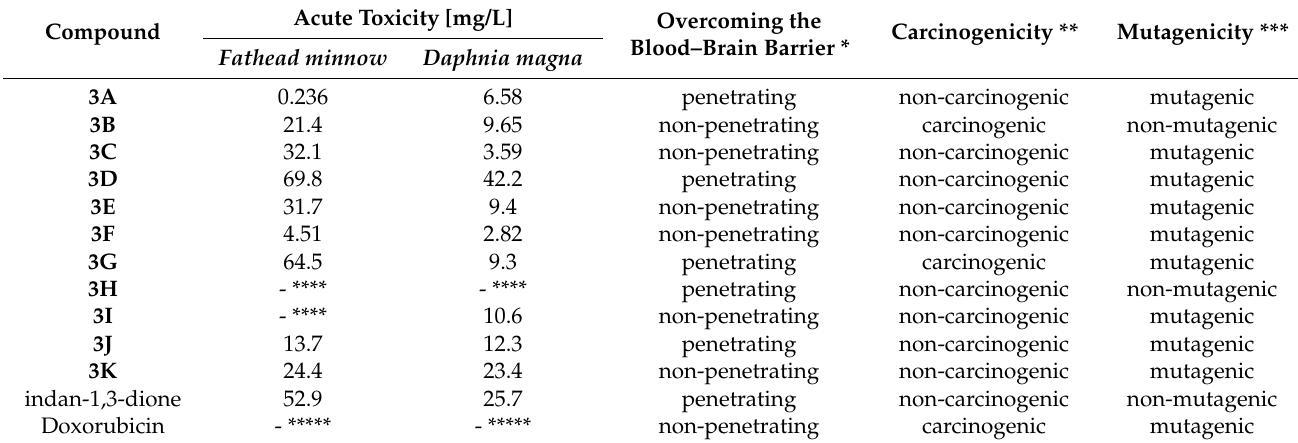
Table 5. Comparison of acute toxicity values and the ability of test compounds to overcome the blood–brain barrier, carcinogenicity, and mutagenicity.